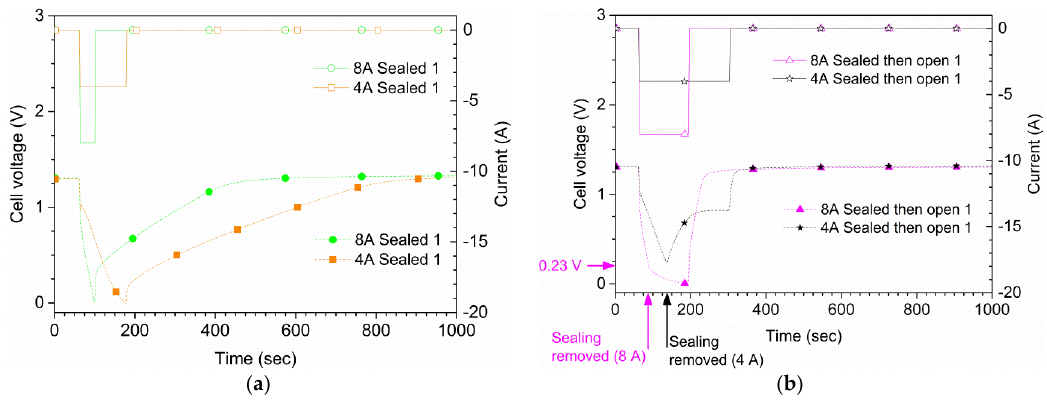
Figure 8. Voltage (filled symbols) and current (open symbols) measurements for cell 1 comparing 4 and 8 A with ( a ) sealed, and ( b ) sealed then open cell.